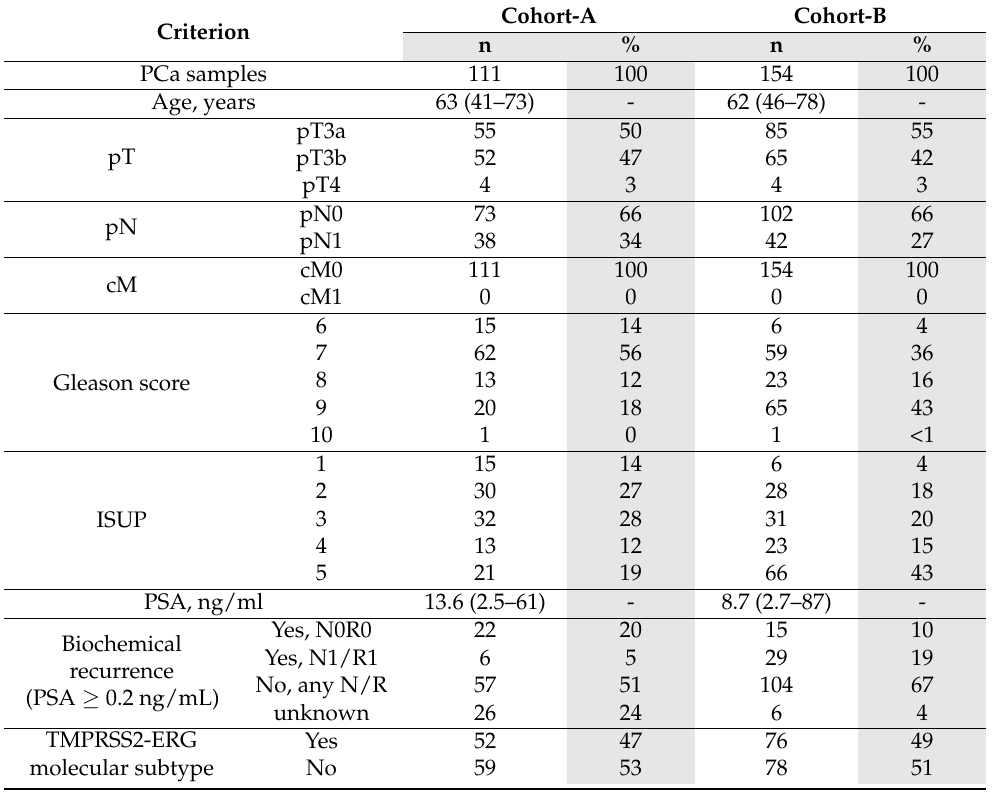
Table 6. Clinical and pathological characteristics of the studied cohorts. pT—primary tumor estima- tion, N—regional lymph nodes, M—distant metastases, R—residual tumor estimation. Criterion